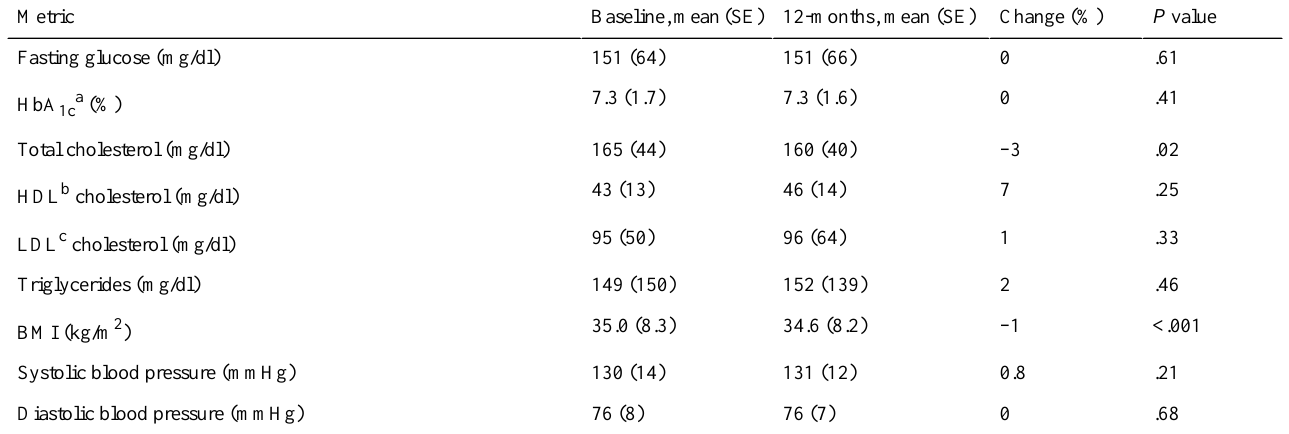
Table 3. Impact of usual care at 12 months.